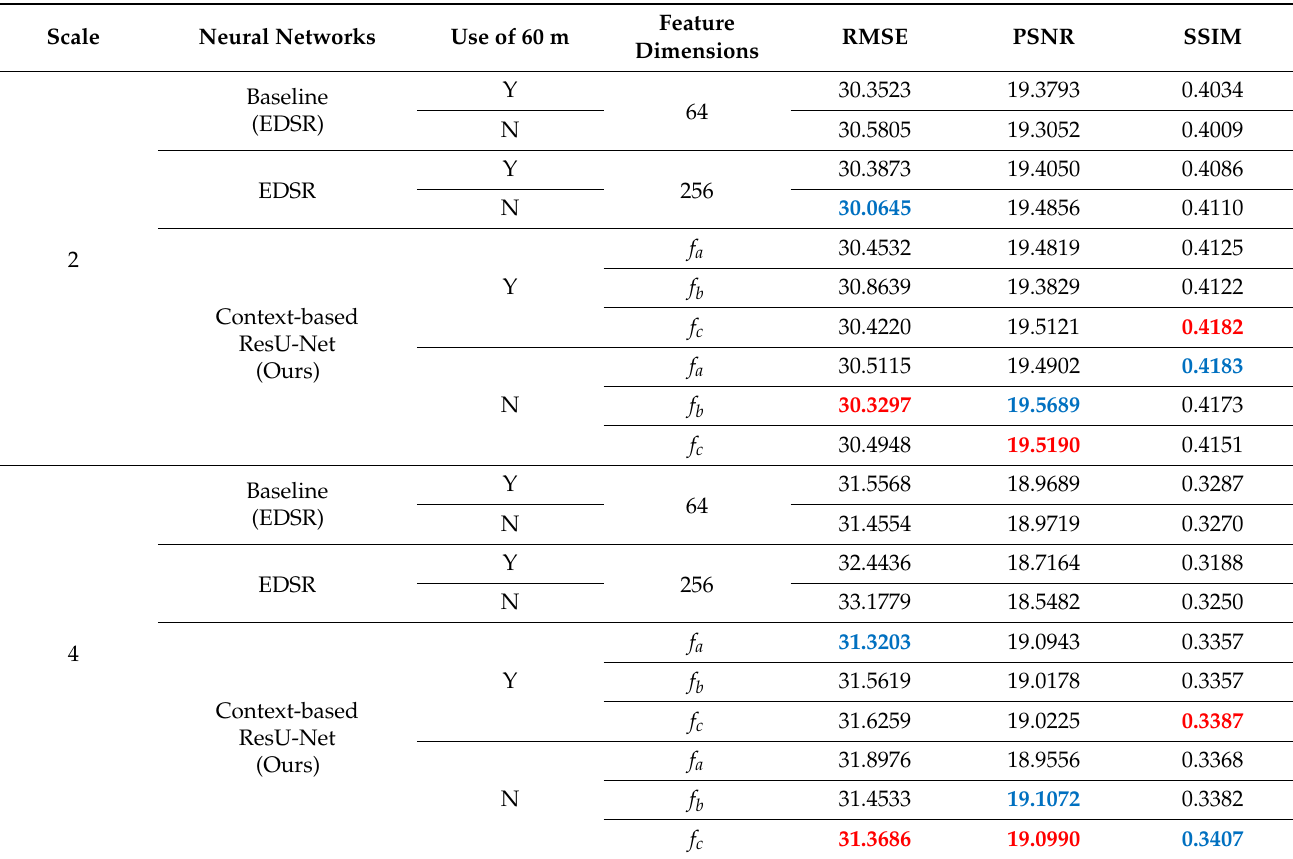
Table 4. Quality evaluation results for Sejong City. Blue indicates the best results, and red indicates the second best.